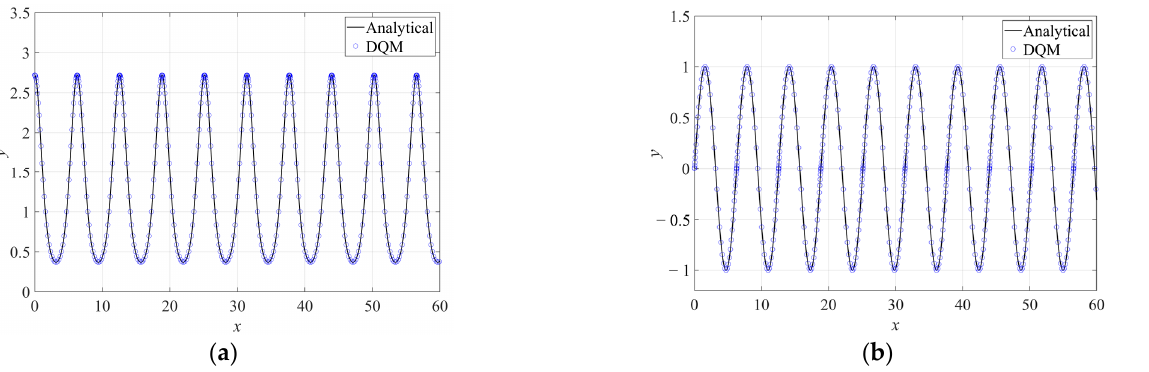
Figure 4. Comparison between DQM and analytical solutions: ( a ) Equation (70) and ( b ) Equation (71). N = 51.